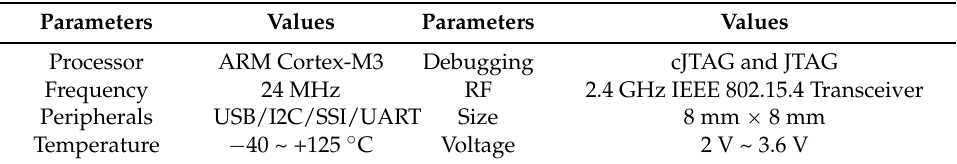
Table 2. Technical specifications for CC2538.